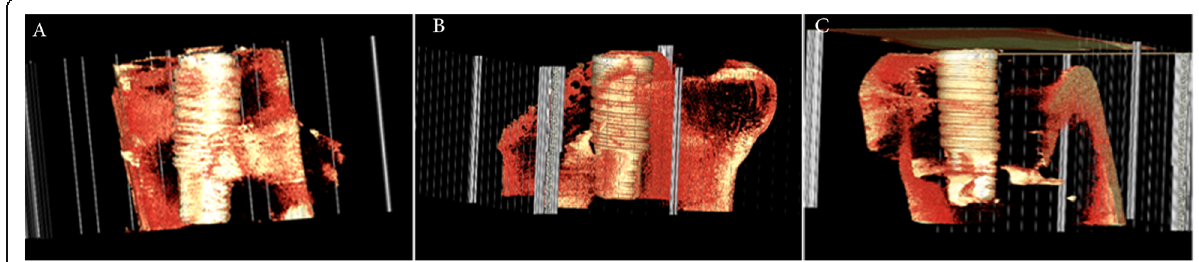
Fig. 4 3D-rendered structure showing the MSCs+PRP+PCL-TCP group ( a ), the PRP+PCL-TCP group ( b ), and the PCL-TCP group ( c ) where more residual scaffold remnants can be observed compared to the other